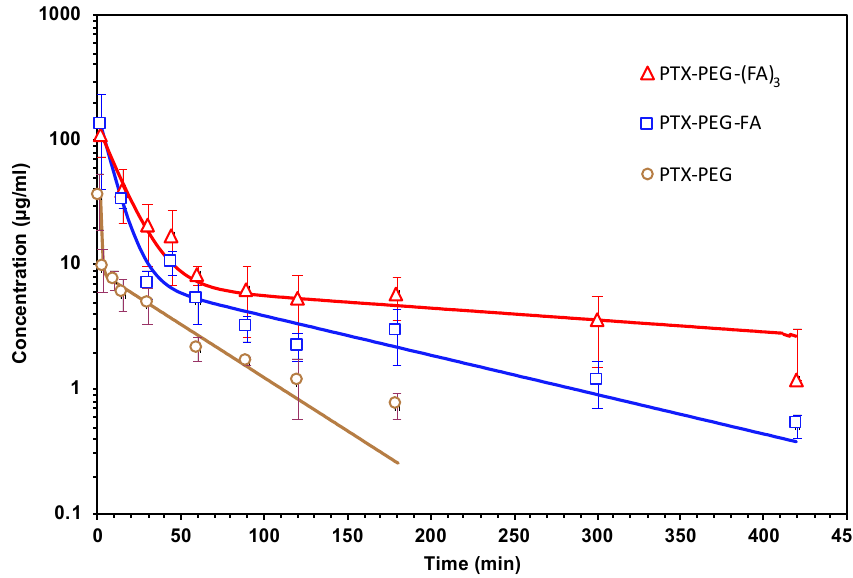
Figure 9. Pharmacokinetic profiles of PTX-PEG-FA and PTX-PEG-(FA) 3 in Balb/C mice after IV administration of 10 mg/kg (PTX equiv.).